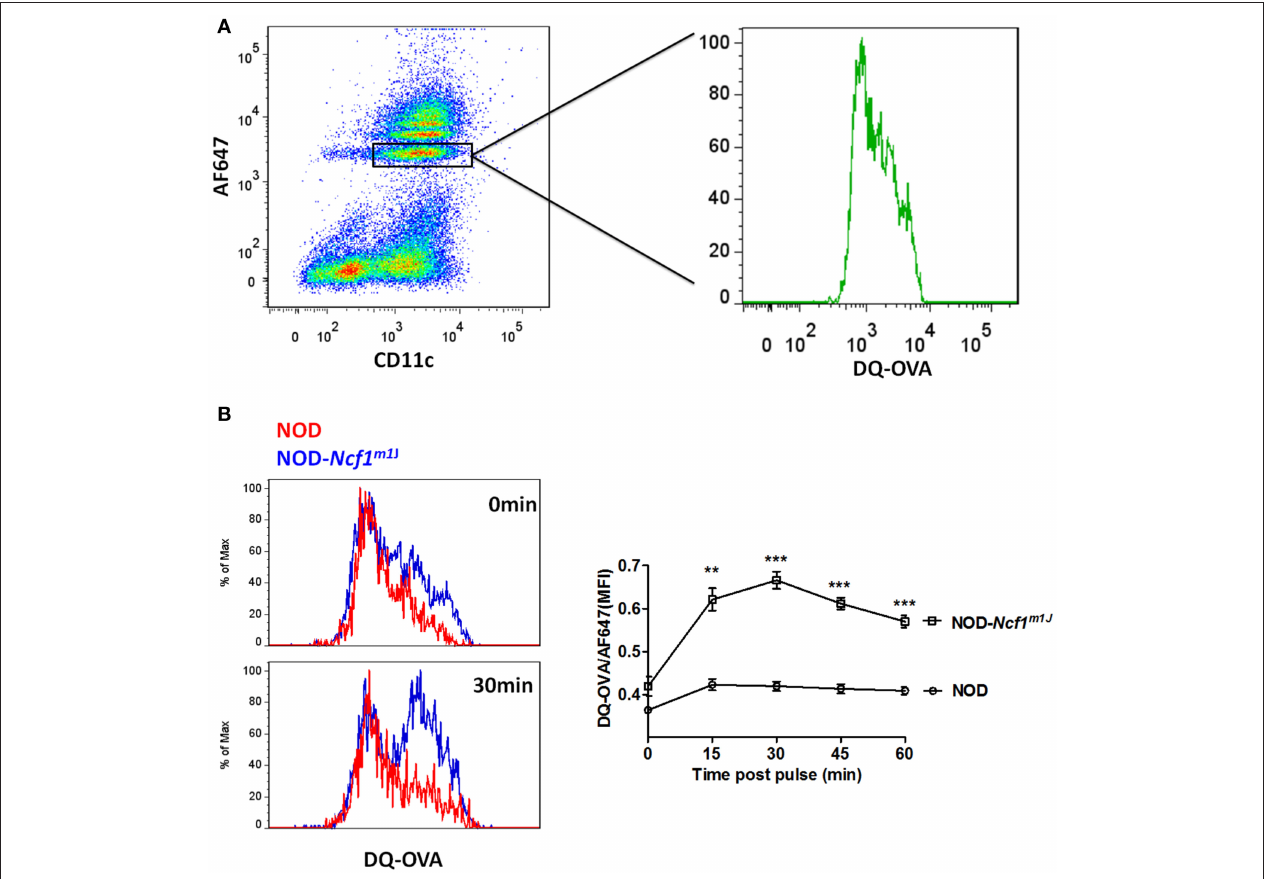
FIGURE 5 | Accelerated antigen degradation in NOD- Ncf1 m1J DCs. (A) Illustration of DQ-OVA analysis using FACS. DCs were incubated with DQ-OVA/AF647 linked latex beads for 15min and cells were analyzed by FACS at different time points after bead wash-off. (B) Histograms and quantitative analysis of DQ-OVA degradation. Data in the bar graph are represented as mean ± SEM. Statistical analysis used Student’s t -test. ** p < 0.01; *** p <